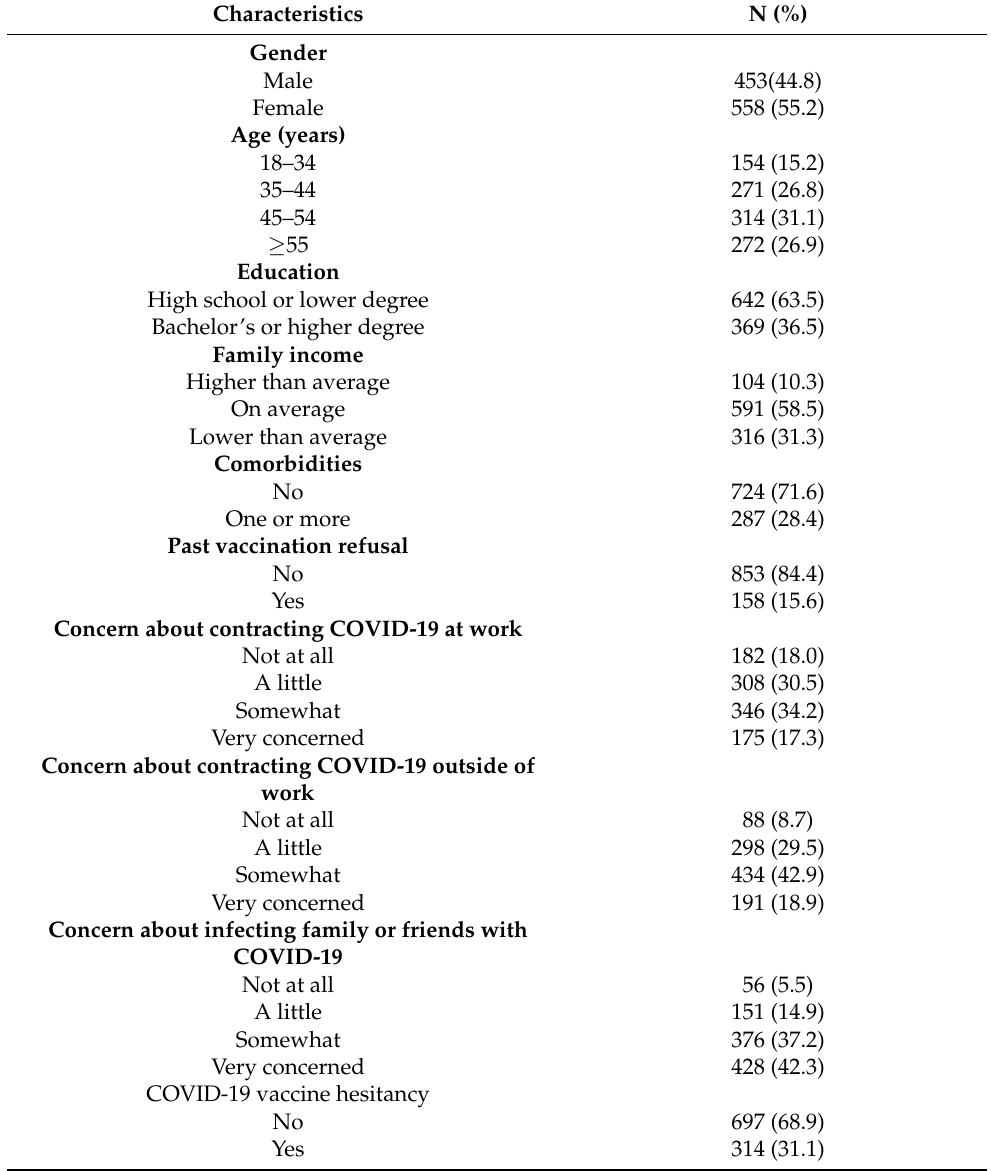
Table 1. Characteristics of the sample (N = 1011).